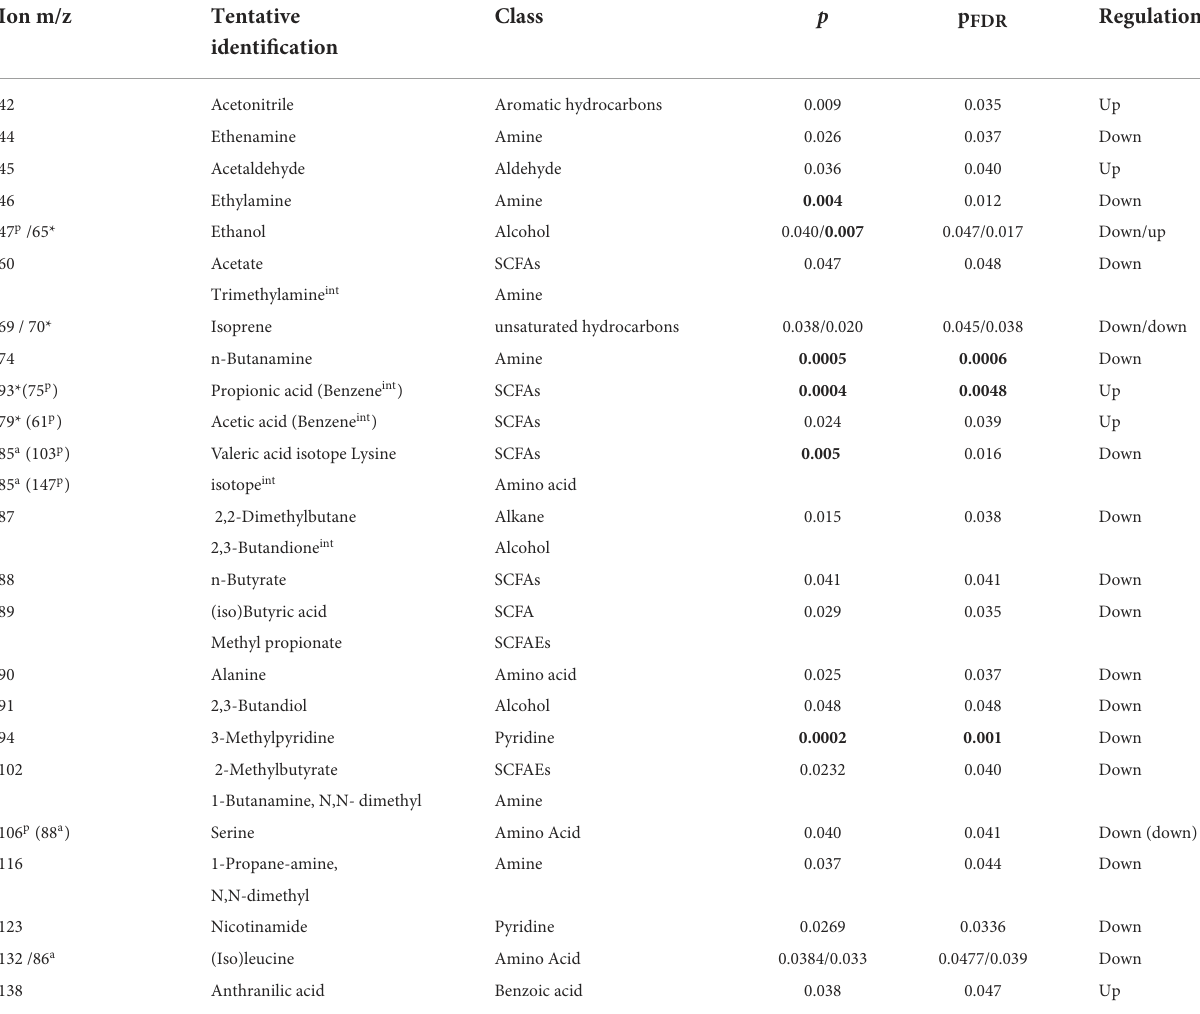
TABLE 2 Significant breath metabolites that discriminate between patients with MDD and HCs at significance level p <